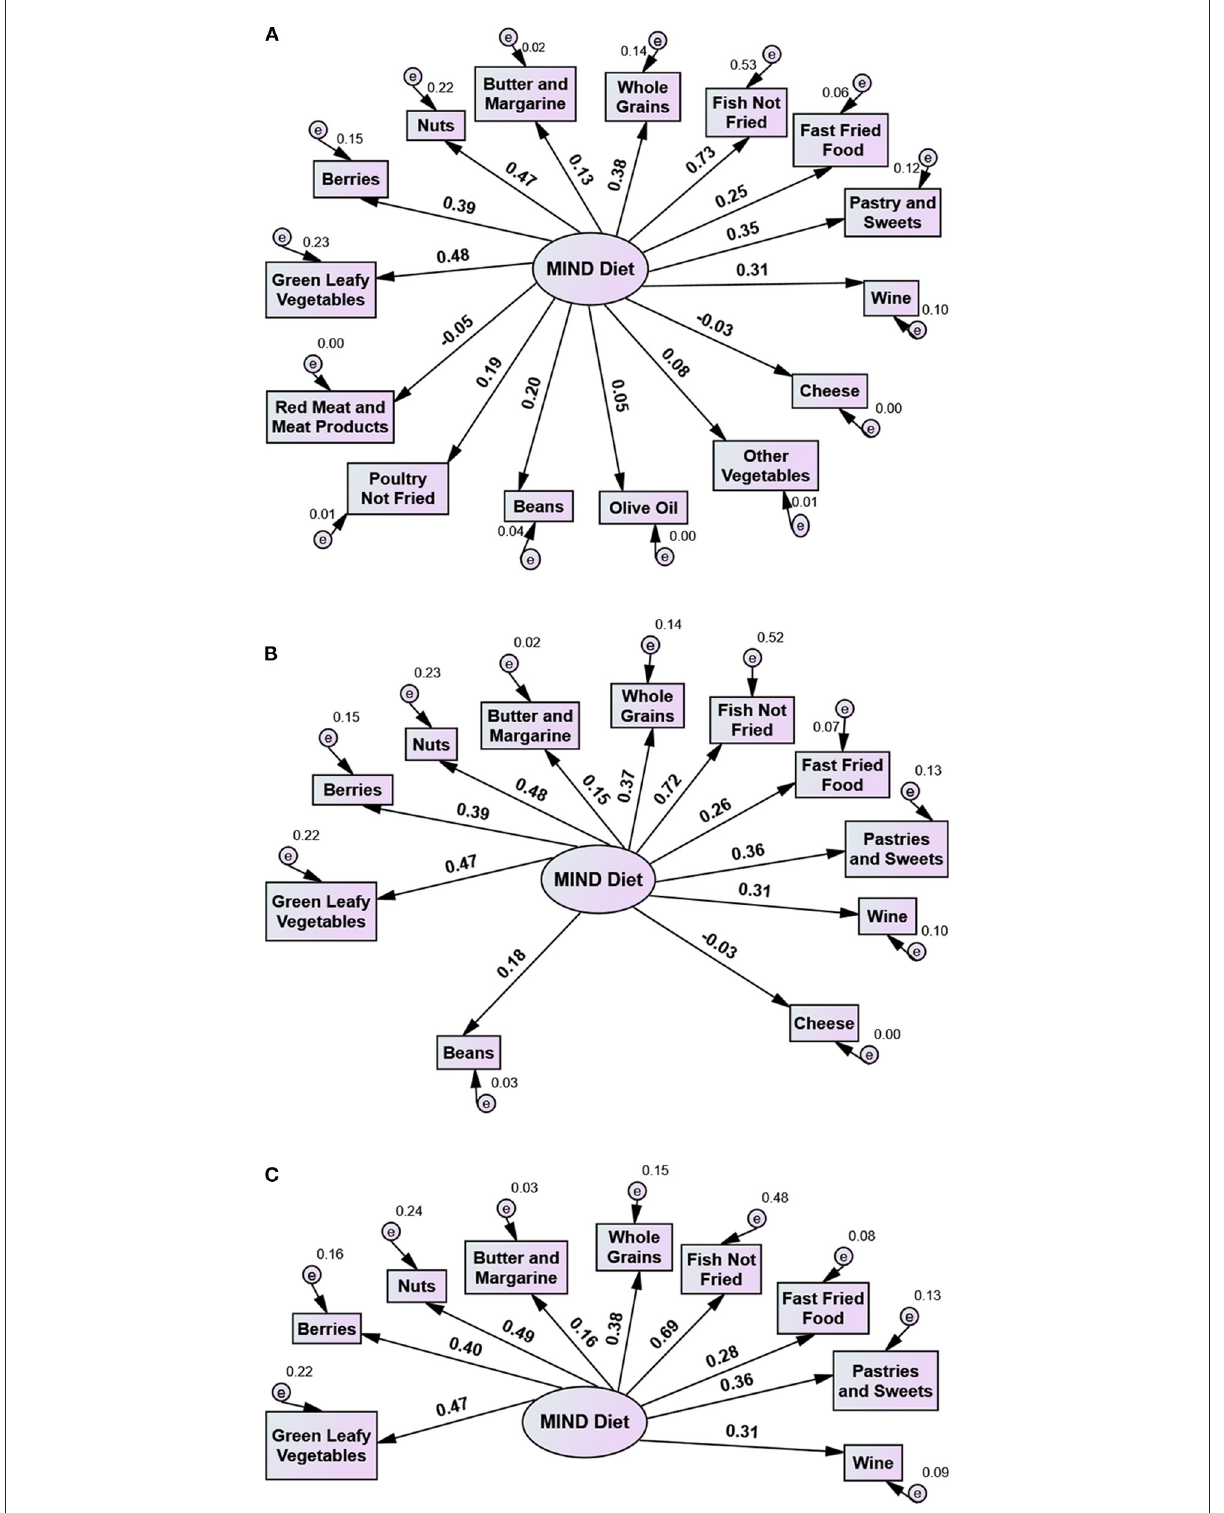
FIGURE1 Use of the MIND Diet tool in a Greek adult population with dementia (patient group) and without dementia (control group): Three 1 factor models with 15, 11, and 9 variables. Numbers on arrows indicate factor loadings (standardized beta weights). (A) Model 1. All diet components of MIND Diet tool: Green Leafy Vegetables, Other Vegetables, Berries, Nuts, Olive Oil, Whole Grains, Beans, Fish Not Fried, Poultry Not Fried,